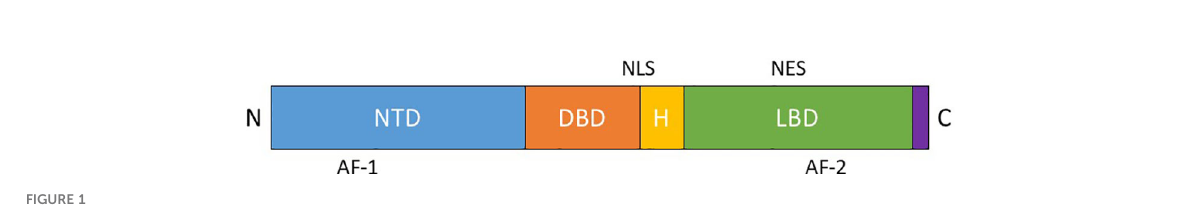
FIGURE 1 Functional domains of the androgen receptor: N-terminal domain (NTD), DNA binding domain (DBD), Ligand binding domain (LBD). (H – hinge region, AF-1 – transcriptional activating function 1, AF-2 – transcriptional activating function 2, NLS – nuclear localization signal, NES – nuclear export